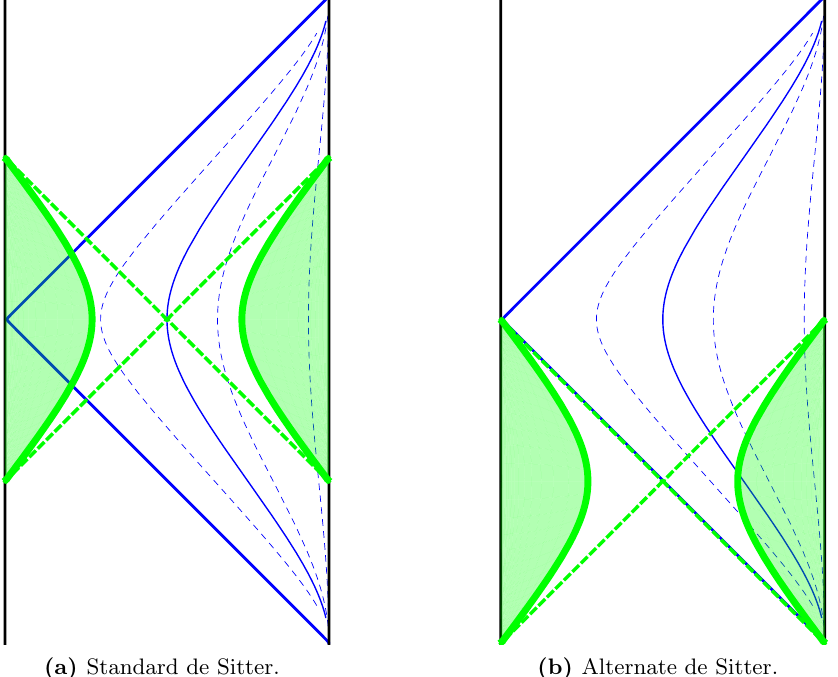
Figure 2. Vertical cross section of de Sitter branes with di(cid:11)erent (cid:28) (cid:3) together with the lines of constant Poincare z